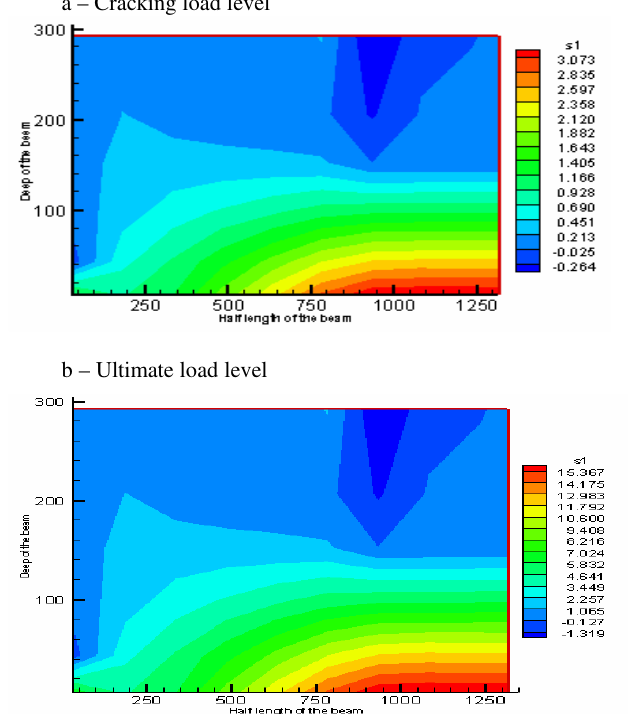
Fig. 10. Major principal stress distribution of perfect bond